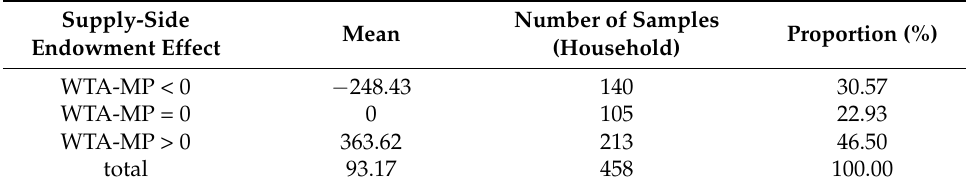
Table 3. Statistical results of the supply-side endowment effect.